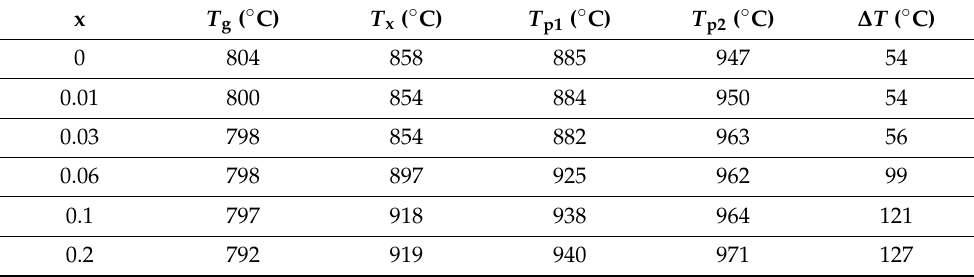
Table 1. Thermal properties, T g , T x , T p1 , T p2 and ∆ T of Al 2 O 3 -(3-x)SrO: xSm 3+ (x = 0, 0.01, 0.03,